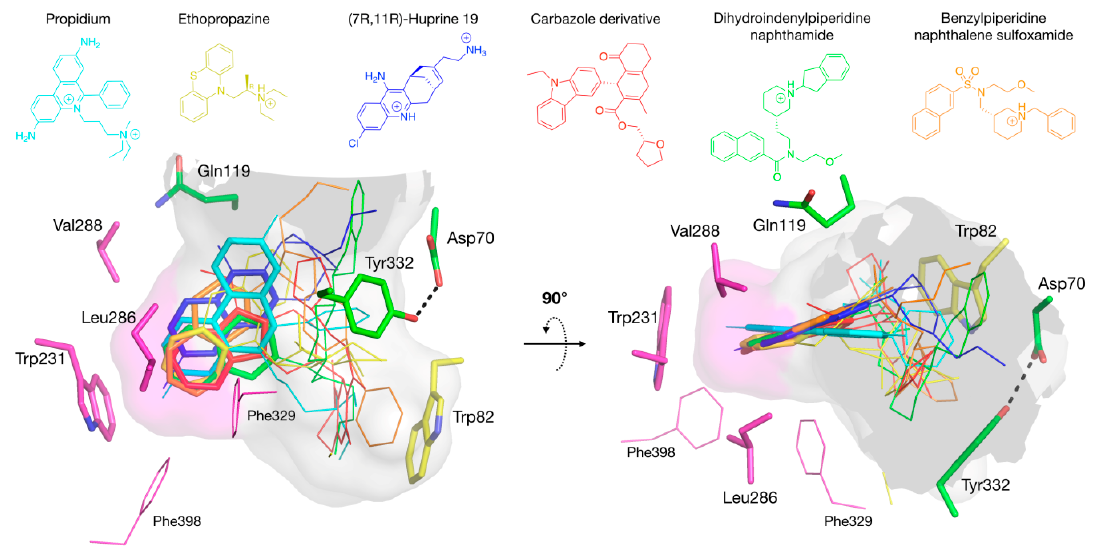
Figure 8. Superimposition of complexes of hBChE with aromatic compounds. In the A-site, choline-binding pocket residues are in yellow and acyl-binding pocket residues in magenta. P-site residues are in green. The gorge is depicted by its molecular surface (semi-transparent gray and magenta for the acyl-binding pocket). The ligands are represented in lines with the aromatic system involved in acyl-binding pocket interaction in sticks: propidium in cyan (pdb 6esj); ethropropazine in yellow (pdb 6eqp); huprine 19 in blue (pdb 6eqq); carbazole derivative in red (pdb 5k5e); dihydroindenylpiperidine naphthamide in green (pdb 4tpk); and benzylpiperidine naphthalene sulfoxamide in orange (pdb 5dyw).